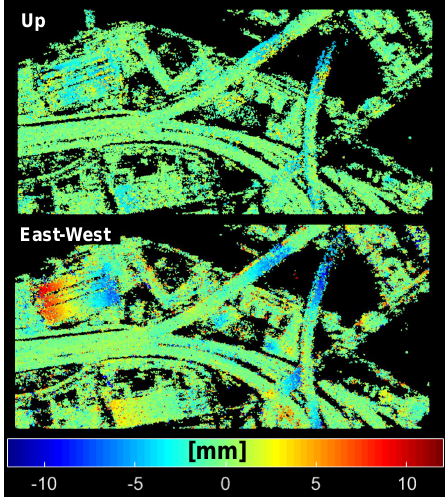
Figure 7. Decomposed seasonal deformation of a railway bridge located in the northeast of Berlin, Germany